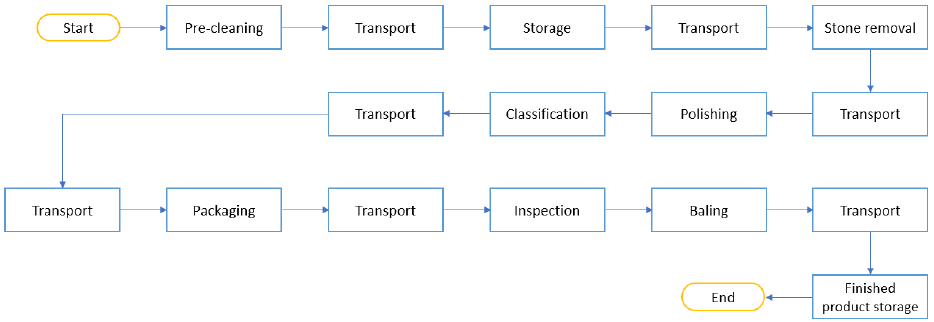
Figure 3. Flowchart of bean processing and packaging